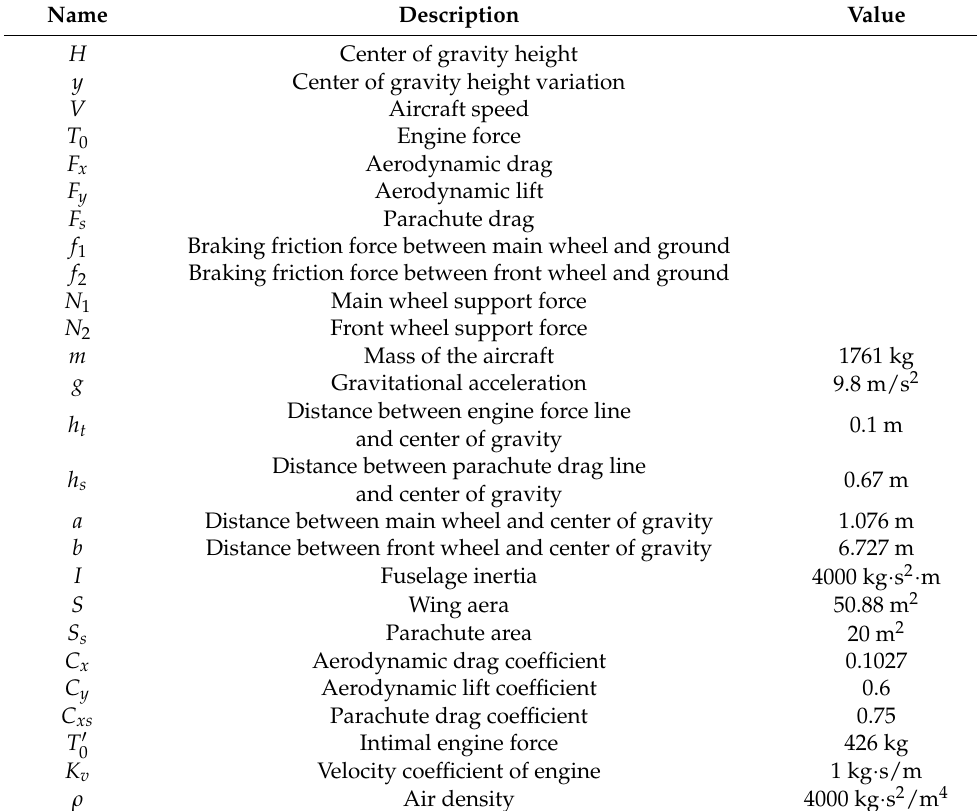
Table 1. Parameters of aircraft fuselage